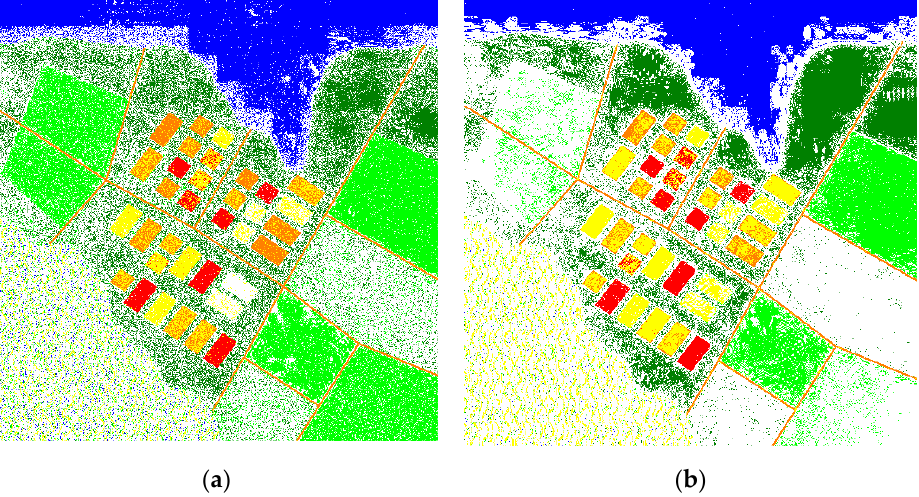
Figure 4. Classification maps for the compressed image with providing PSNR-HVS-M = 36 dB using maximum likelihood method (MLM) classifier trained for the same compressed image ( a ); compressed image with providing PSNR-HVS-M = 30 dB using MLM classifier trained for the same compressed image ( b ).